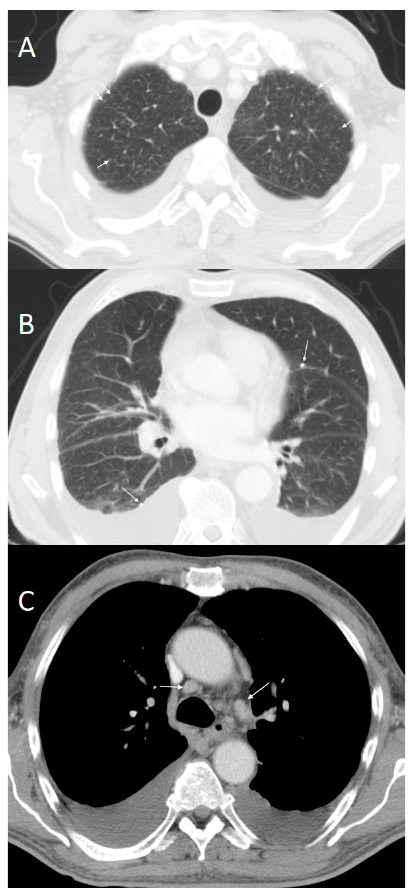
Figure 1. CT axial scans in pulmonary and soft tissue window revealed: ( A ) multiple small pul- monary nodules distributed predominantly in the upper lobes (white arrows); ( B ) nodules accom- panied by calcifications (white arrows); and ( C ) mediastinal lymphadenopathy (white arrows) and bilateral